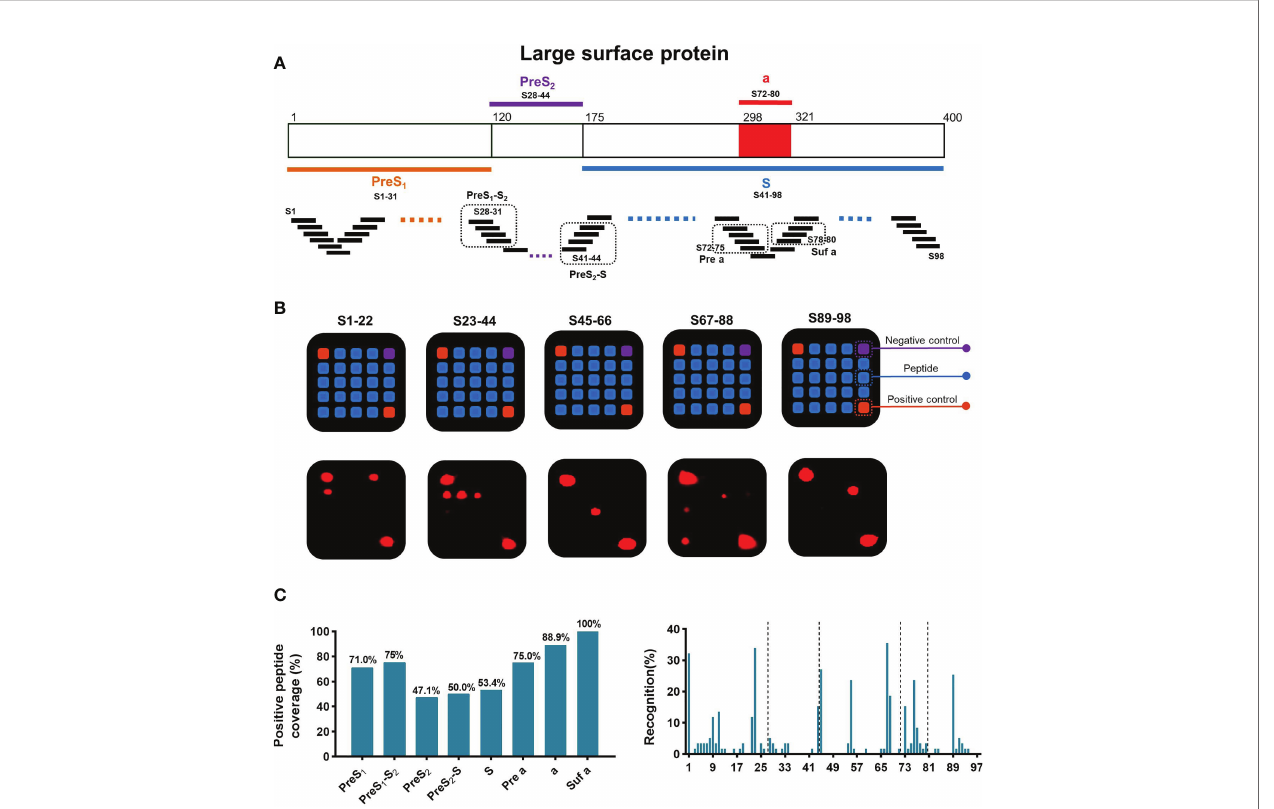
FIGURE 2 | General recognition of linear B-cell epitopes on S protein by peptide array. (A) Schematic of the large surface proteins PreS 1 , PreS 2 , and S. In the diagram of S, the “ a determinant region ” is red. Design of peptide array. Fifteen-mer overlapping peptides covering the entire S protein were shown. According to the classical regions of the large S protein, these peptides were classi fi ed into 8 subpartitions: PreS 1 (S1 – 31), PreS 1 -S 2 (S28 – 31), PreS 2 (S28 – 44), PreS 2 -S (S41 – 44), S (S41 – 98), Pre a (S72 – 75), a (S72 – 80), and Suf a (S78 – 80). (B) Representative peptide array. Design of the 5*5 peptide array; for each subarray, there were negative and positive controls (top). Five representative subarrays with positive results (bottom). (C) Positive peptide coverage in subpartitions and recognition rate of each peptide in patients with chronic HBV